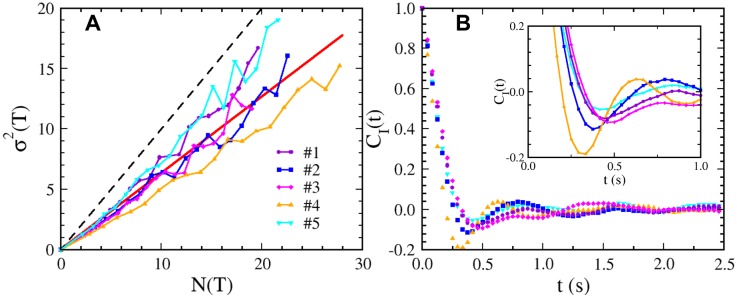
Measurements from five V. alginolyticus bacteria each being tracked for ten minutes.(A) σ
2 vs. N for five bacterial trajectories #1-#5 are displayed as indicated by the legend. The dashed black line represents σ
2/N = 1. Assuming that σ
2 vs. N is linear, a linear regression using the data from the five cells yields a straight line with a slope (or Fano factor) of 0.63, which is represented by the red line. (B) The autocorrelation functions C
I(t) computed using the time series I(t′) for the five cells (see legend in (A)), where I(t′) = −1 for CW and +1 for CCW motor state (see main text). The inset displays short-time oscillations with more details.